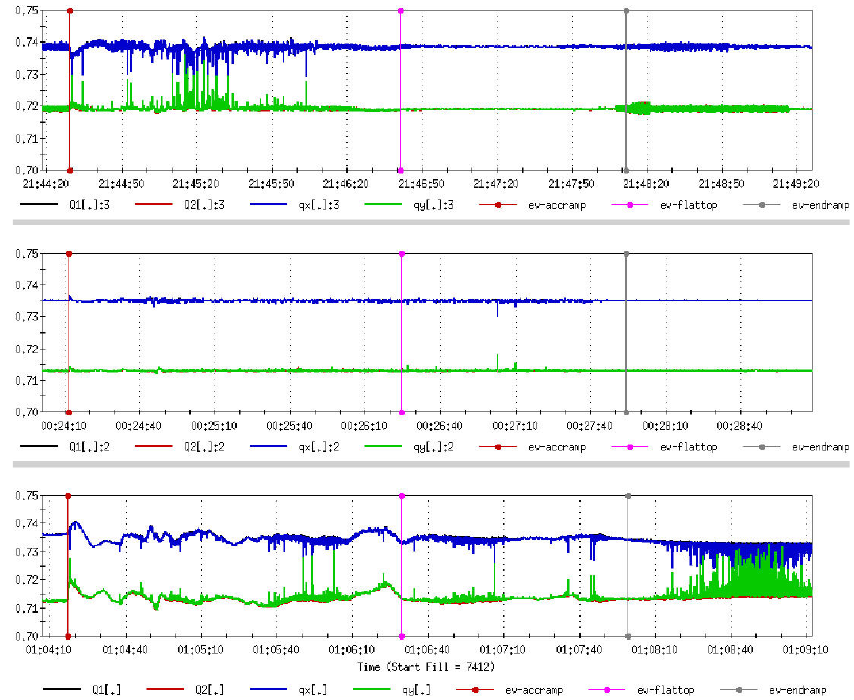
FIG. 13. (Color) Data from 100 GeV development ramps in RHIC run